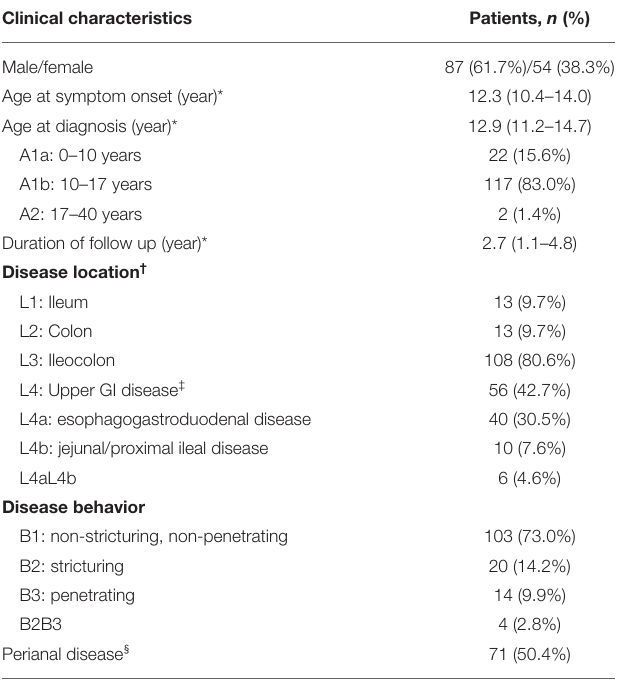
TABLE 1 | Demographic characteristics and clinical features of patients ( n = 141).